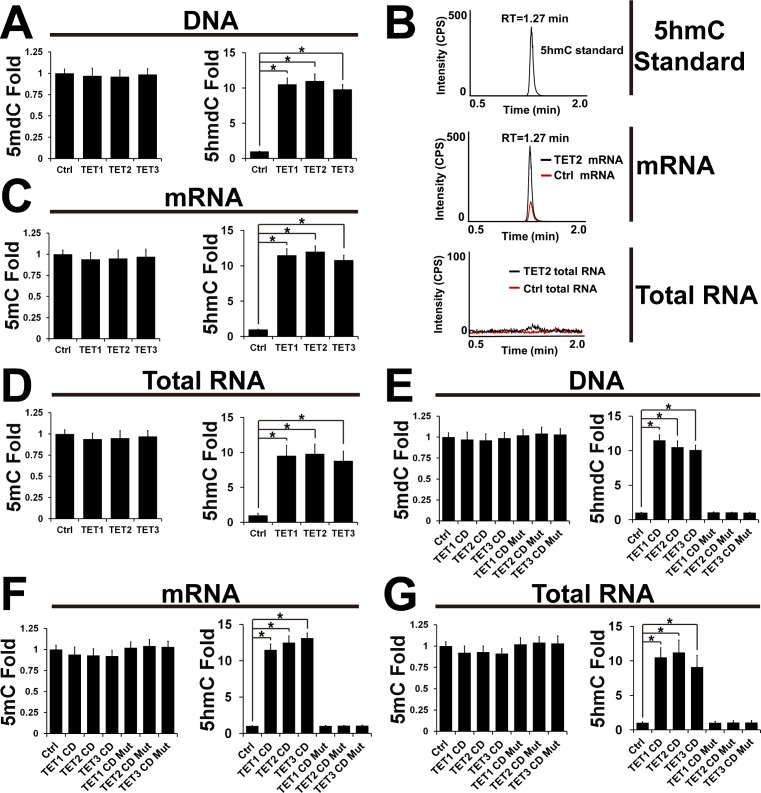
Overexpression of TETs significantly increases RNA 5hmC in human HEK293 cells.(A) HEK293 cells were transfected with pS-Flag-SBP (control), pS-Flag-SBP TET1, pS-Flag-SBP TET2 or pS-Flag-SBP TET3. After 48 hrs, DNA was extracted, digested and analyzed by mass spectrometry as described in Methods and Materials. The 5mdC level (5mdC/dC) and 5hmdC level (5hmdC/dC) were normalized. The 5mdC and 5hmdC levels in the cells transfected with pS-Flag-SBP were taken as control (Ctrl) and considered as 1. In this study, n = 3, ± SEM, and *p< 0.05 were applied unless otherwise stated. (B) The total ion chromatogram (TIC) of RNA 5hmC. Both mRNA and total RNA from (A) were extracted and digested. Resultant 6 μg of mRNA (or 6 μg of total RNA) were analyzed by LC-MS/MS as noted. TIC of RNA 5hmC represents the signal intensity normalized to RNA C level in the cells transfected with pS-Flag-SBP. RT: retention time. More details are described in Methods and Materials. (C) LC-MS/MS analysis of the mRNA (6μg) from (A). (D) LC-MS/MS analysis of the total RNA (60 μg) from (A).(E) HEK293 cells were transfected with pCDNA3 (control), pCDNA3B-Flag-TET1 CD, pCDNA3B-Flag-TET1 CD mut, pCDNA3B-Flag-TET2 CD, pCDNA3B-Flag-TET2 CD mut, pCDNA3B-Flag-TET3 CD or pCDNA3B-Flag-TET3 CD mut. After 48 hrs, DNA was extracted, digested and analyzed by LC-MS/MS. The cells transfected with pCDNA3 were taken as control (Ctrl). (F) LC-MS/MSanalysis of the mRNA from (E). (G) LC-MS/MS analysis of the total RNA from (E).